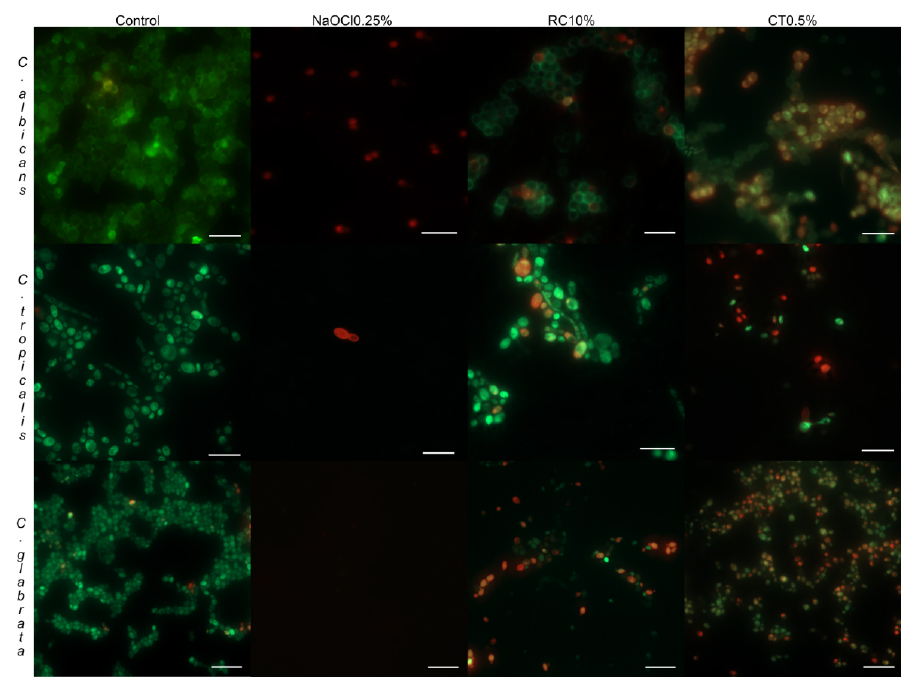
Figure 6- Epifluorescence microscopy images of the C. albicans , C. tropicalis and C. glabrata biofilm in the specimens after immersion in disinfectant and negative control (Scale bar =